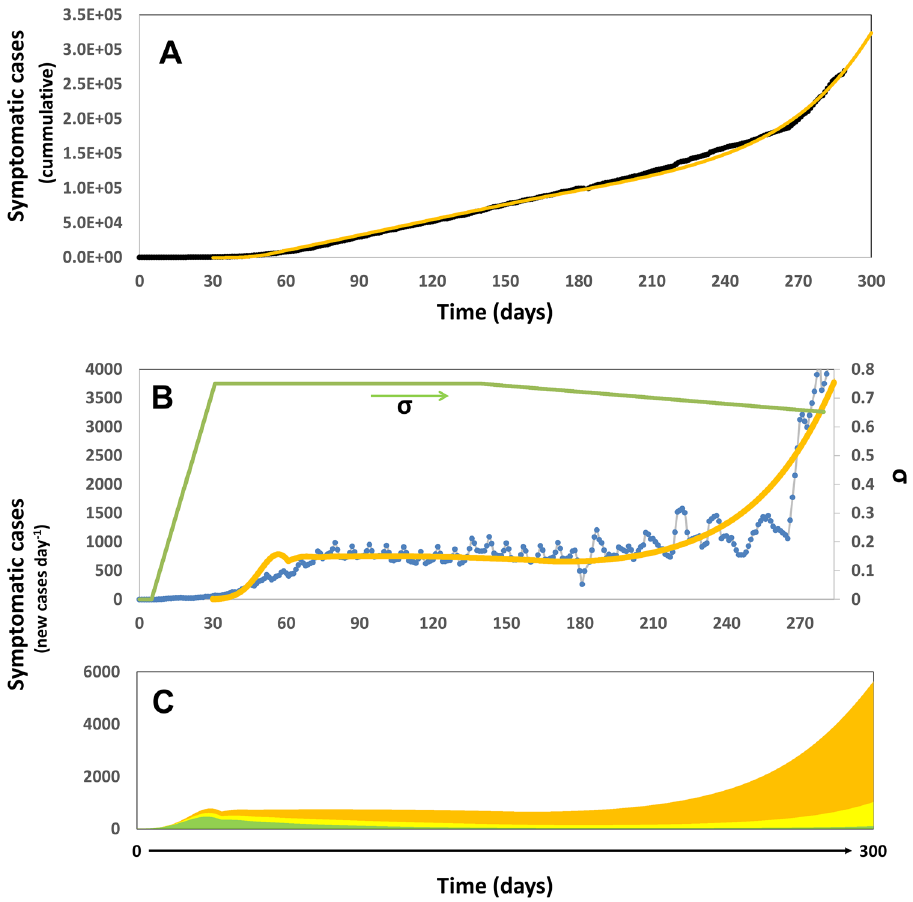
Figure 5. Progression of the COVID-19 Pandemic in Mexico City. ( A ) Model prediction of the total number of symptomatic patients through the months of Mach and December, 2020. Actual data points, as officially reported, are shown using black circles. Simulation predictions are described by the yellow line. The profile of social distancing (σ) is shown as a green line. A constant value of α = 0.10 was used in this simulation. ( B ) Model prediction (yellow line) and actual number of new cases of COVID-19 per day (as reported by the Mexican authorities; blue line; https ://www.fast-track citie s.org/conte nt/data-visua lizat ion-mexic o-city-covid ) during the period from February to December, 2020. ( C ) Prediction of the number of new cases of COVID-19 per day if the testing effort would have been doubled (light yellow area) or tripled (green area). The simulation of the actual pandemic scenario is also shown (yellow-orange